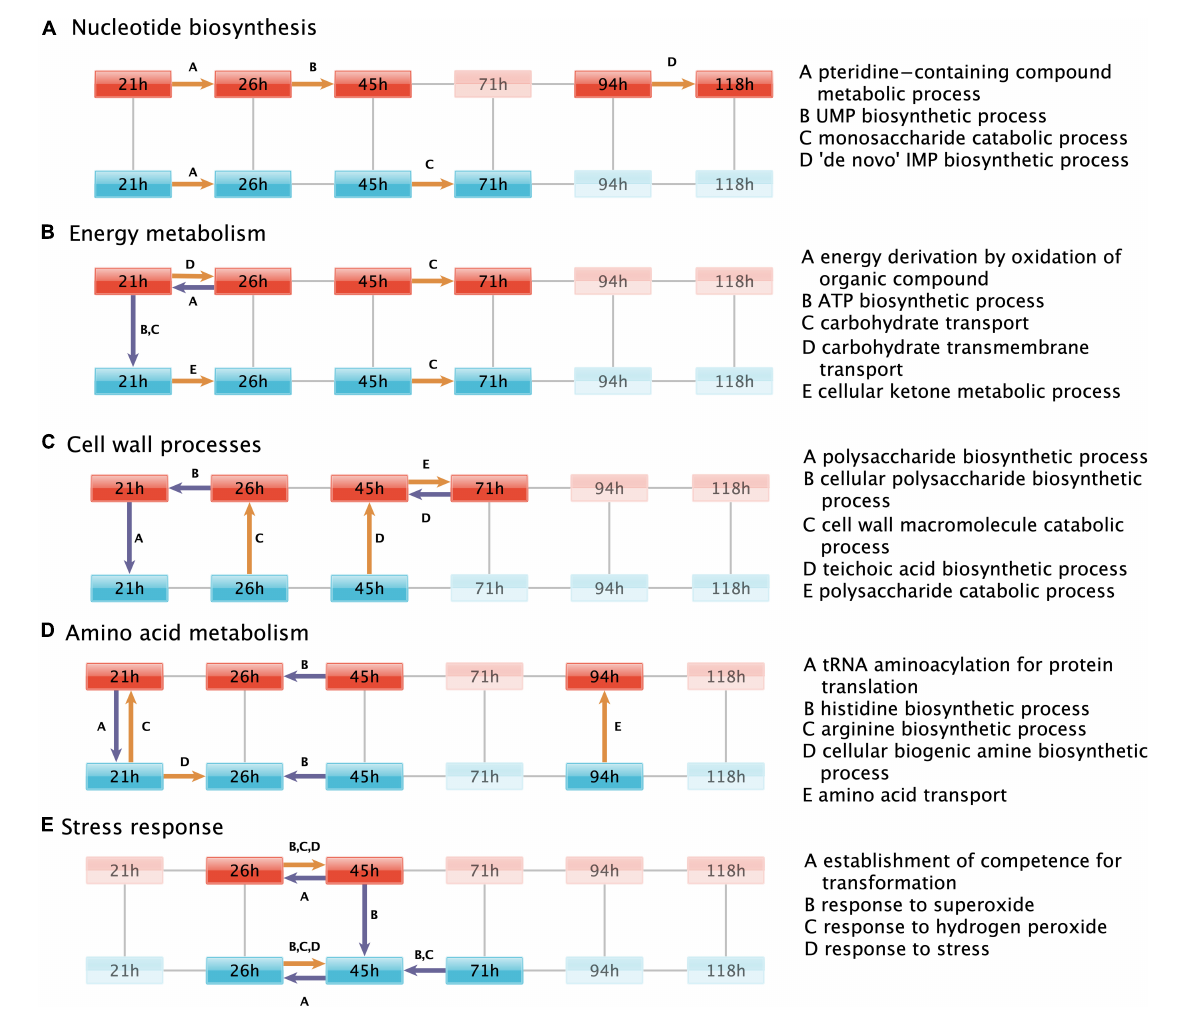
FIGURE3 Regulated biological processes. Biological processes that are over-represented by the genes differentially expressed in each of the pairwise comparisons (black lines) between the fermentation timepoint in the +prsA (red) and control strain (blue). For simplicity, the regulated processes are grouped in subplots according to the same biological functions discussed in the result sections, which touch upon (A) nucleotide biosynthesis, (B) energy metabolism, (C) cell wall processes, (D) amino acid metabolism, and (E) stress response. Supplementary Figure 7 shows the regulated processes without further functional subdivision. Colored arrows indicate a pairwise comparison that was over-represented in a process (see description to the right). The arrows point to the conditions in which expression levels were